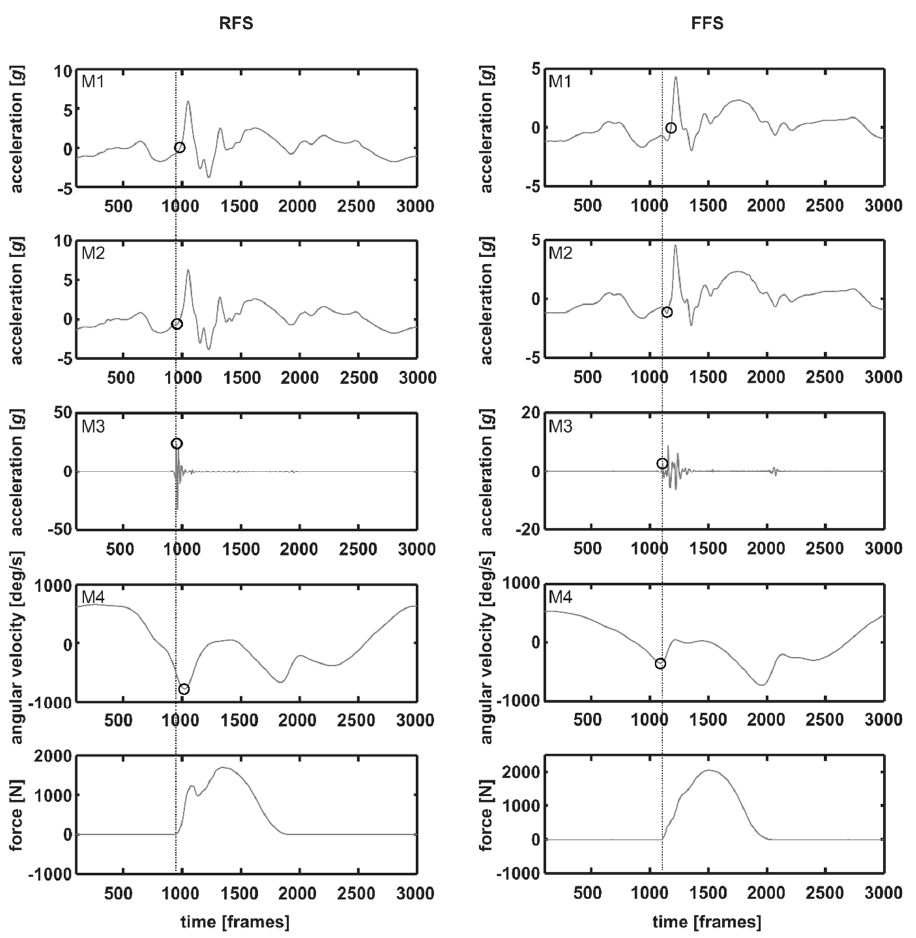
Figure 1. Foot strike detection methods M1 to M4 (O) and reference method (vertical component of ground reaction forces >20 N is represented by dotted line) for rearfoot strike pattern (RFS) and forefoot strike pattern (FFS), for one representative trial (sampling rate 3750 Hz).